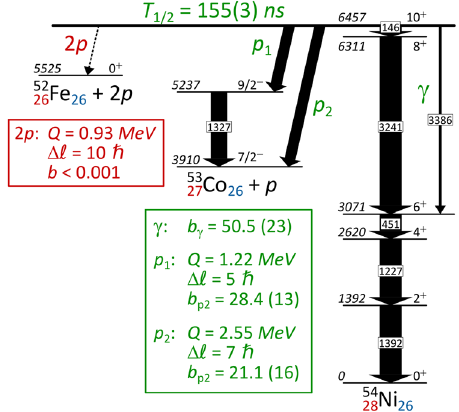
Fig. 1 Decay scheme of 54m Ni. The scheme is based on previous 19 and present results. Level energies are in keV and measured relative to the ground state of 54 Ni. The p1 proton to the fi rst excited state of 53 Co was indirectly evidenced previously; the proton emission to the ground state (p2) is observed in the present work. The two-proton emission branch (pp) is also energetically possible, but is very unlikely because of its small